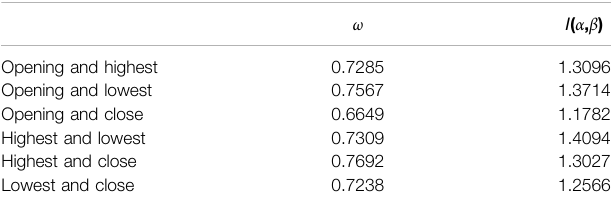
TABLE 3 | Parameter obtained for the two layered networks for different combinations of time series data for Ping An Bank Co.